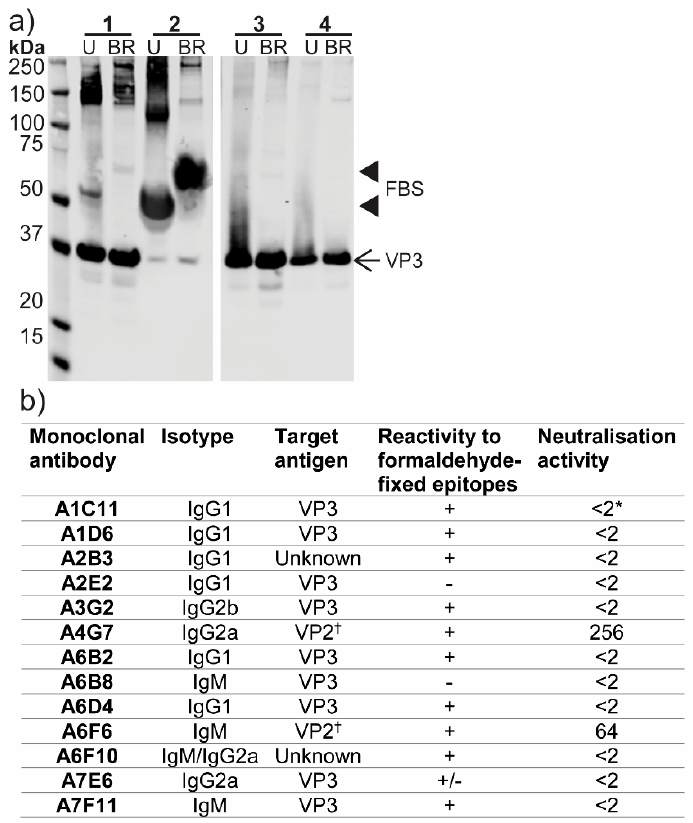
Figure 7. Antibody response to ABV. ( a ) Reactivity of anti-ABV mouse immune serum to ABV in Western blot. Lane 1, supernatant from ABV-infected C6 / 36 cells grown in minimal ( < 1%) FBS; 2, ABV virus stock supernatant from C6 / 36 cells, supplemented with 10% FBS; 3, CsCl gradient-purified preparation one of ABV in PBS; 4, CsCl gradient-purified preparation two of ABV in PBS. U, unreduced; BR, boiled and reduced. ( b ) Summary of ABV-specific monoclonal antibody panel. † Most likely target based on neutralizing activity. * Highest reciprocal dilution at which virus infectivity is inhibited. –, OD450 nm < 0.25 and less than two times the average OD of the negative control; + , OD450 nm is > 0.5 and at least two times greater than the average OD of negative control; +/ -, positive result but inconsistent between